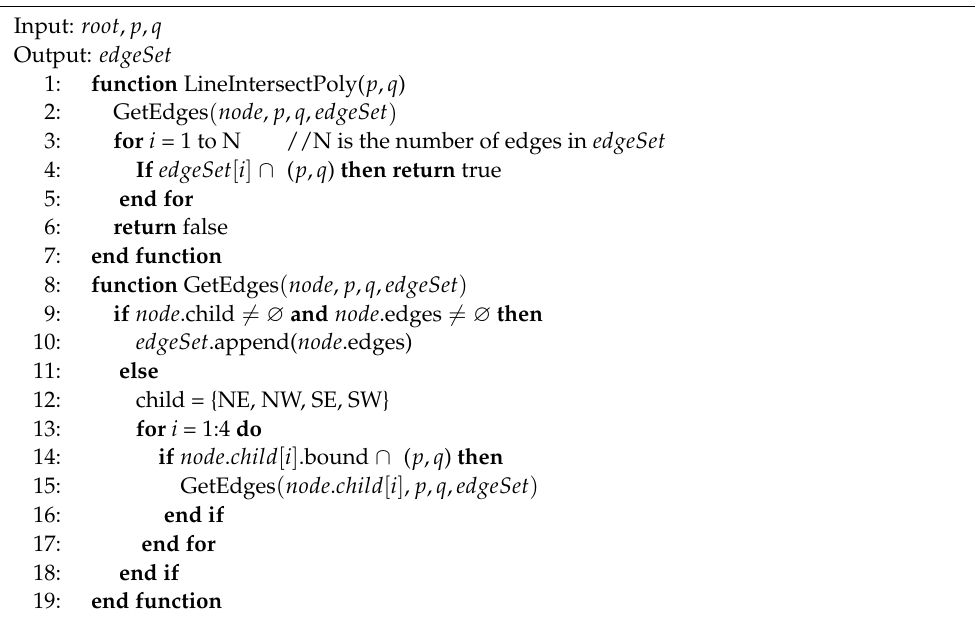
Algorithm 1 Edge acquisition in quads intersecting with